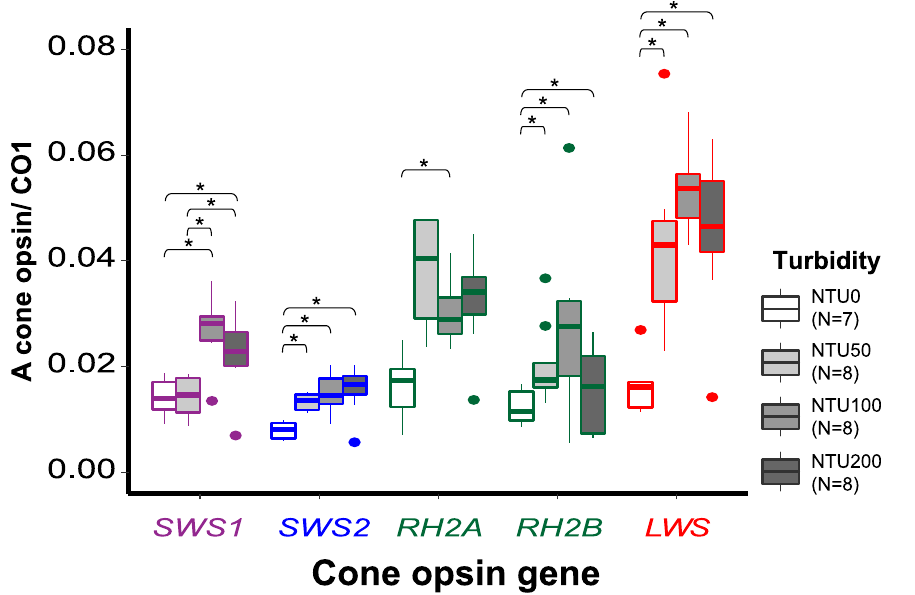
Fig 4. Box plot showing the median (—), 25 th and 75 th percentiles (box), 95% range (|), and outliers (•) of cone opsin relative expression values for different turbidity treatments. An asterisk indicates P < 0.05 (one-way ANOVA, post hoc Tukey’s comparisons). The box color of each opsin family represents its general λ max range. SWS1 ’s is ultraviolet light, SWS2 ’s is blue light, RH2 ’s is green light, and LWS ’s is red light.